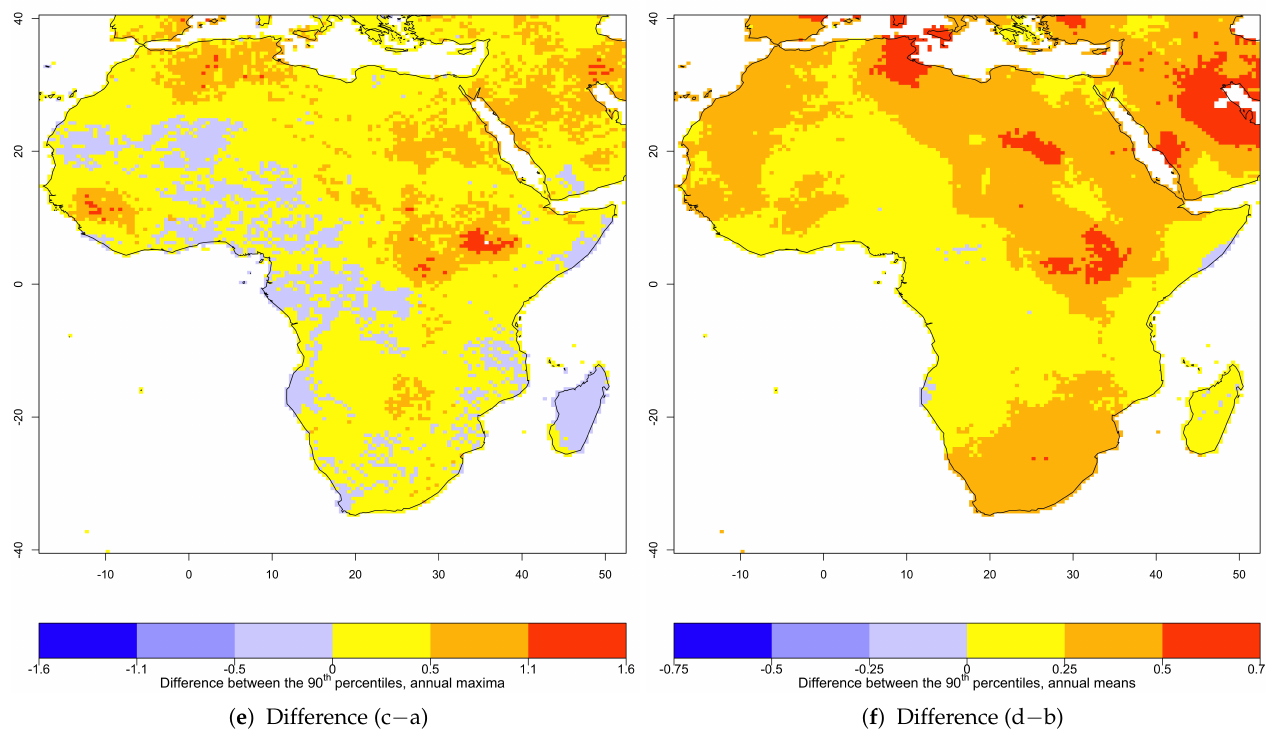
Figure 2. The two thresholds that define extreme event in this study (90th percentiles of distributions over 1901 to 2000 and 1901 to 2019) for annual maxima and annual means; and difference between these: ( a ) the 90th percentile of annual maxima Climate 2021 , 1 , 0 over 1901 to 2000, ( b ) the 90th percentile of annual means over 1901 to 2000, ( c ) the 90th percentile of annual maxima over 1901 to 2019, ( d ) the 90th percentile of annual means over 1901 to 2019, ( e ) difference between the 90th percentiles of annual maxima [c a] and ( f ) difference between the 90th percentiles of annual means [d −